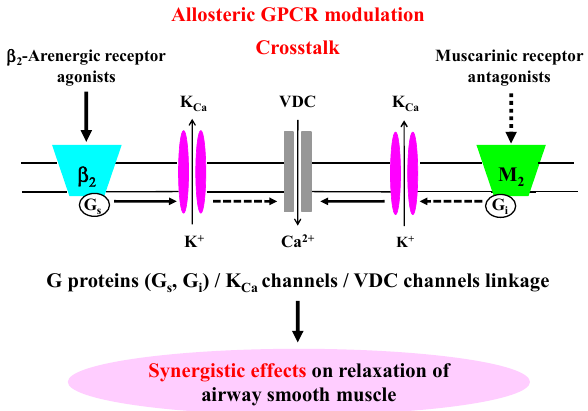
Figure 8. Possible clinical relevance of the synergistically relaxant effects between β 2 -adrenergic receptor agonists and muscarinic receptor antagonists. This synergism is caused by crosstalk based on allosteric GPCR modulation via G proteins (G i , G s )/K Ca channel/VDC channel processes. Since this synergism causes greater bronchodilation, combining two agents may be beneficial to therapy for asthma and COPD. GPCR: G protein-coupled receptor, G i : the inhibitory G protein of adenylyl cyclase coupled to M 2 receptors, G s : the stimulatory G protein of adenylyl cyclase coupled to β 2 -adrenergic receptors, K Ca : large-conductance Ca 2+ -activated K + channels, VDC: L-type voltage-dependent Ca 2+ channels. Arrows: activation, dotted arrows: inhibition.